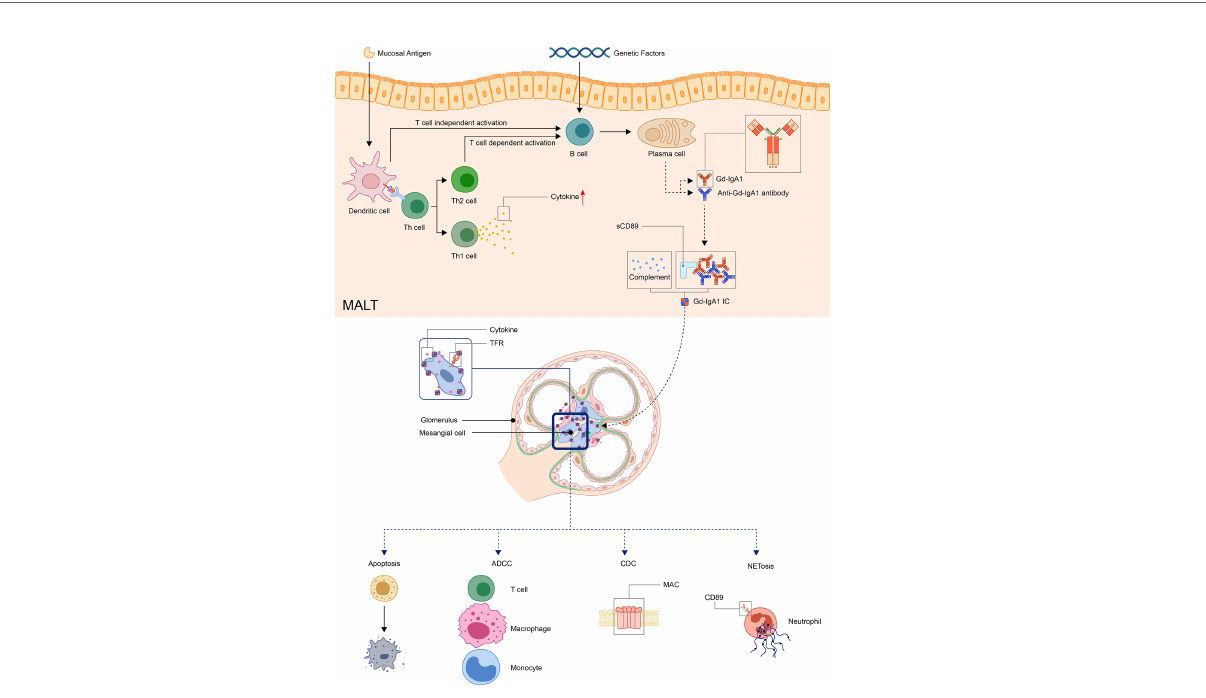
FIGURE 1 | Model: pathogenesis of IgA vasculitis. The mucosal antigen can activate B-cells in MALT through T-cell-dependent or independent ways. The latter activates B-cells through TLR pathways. With genetic factors, the activated B-cells become plasma cells and produce Gd-IgA1. Gd-IgA1 and anti-Gd-IgA1 autoantibodies form circulating immune complexes together with other components (including sCD89 or complements). Then, the immunocomplex deposit at organs and activate in fl ammatory responses. In the kidney, the immunocomplex can activate mesangial cells through TfR, leading to the apoptosis of renal cells and recruitment of in fl ammatory cells. (ADCC, antibody-dependent cytotoxicity; CDC, complement-dependent cytotoxicity; Gd-IgA1, Galactose-de fi cient IgA1; MAC, membrane attack complex; MALT, Mucosa-associated lymphoid tissue; NET, neutrophil extracellular traps; TfR, transferrin